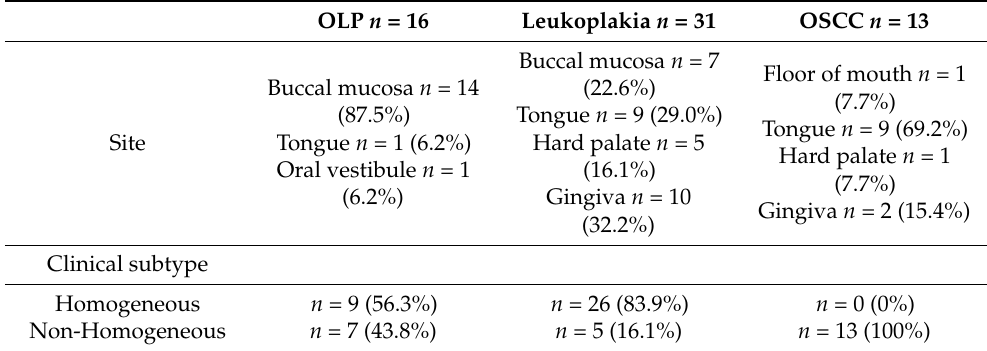
Table 1. Study cohort demographics, and anatomopathological and clinical characteristics, including the numbers of oral lichen planus (OLP), clinical oral leukoplakia, and oral squamous cell carcinoma (OSCC). The pathological diagnoses of clinical oral leukoplakia were hyperkeratosis ( n = 1,